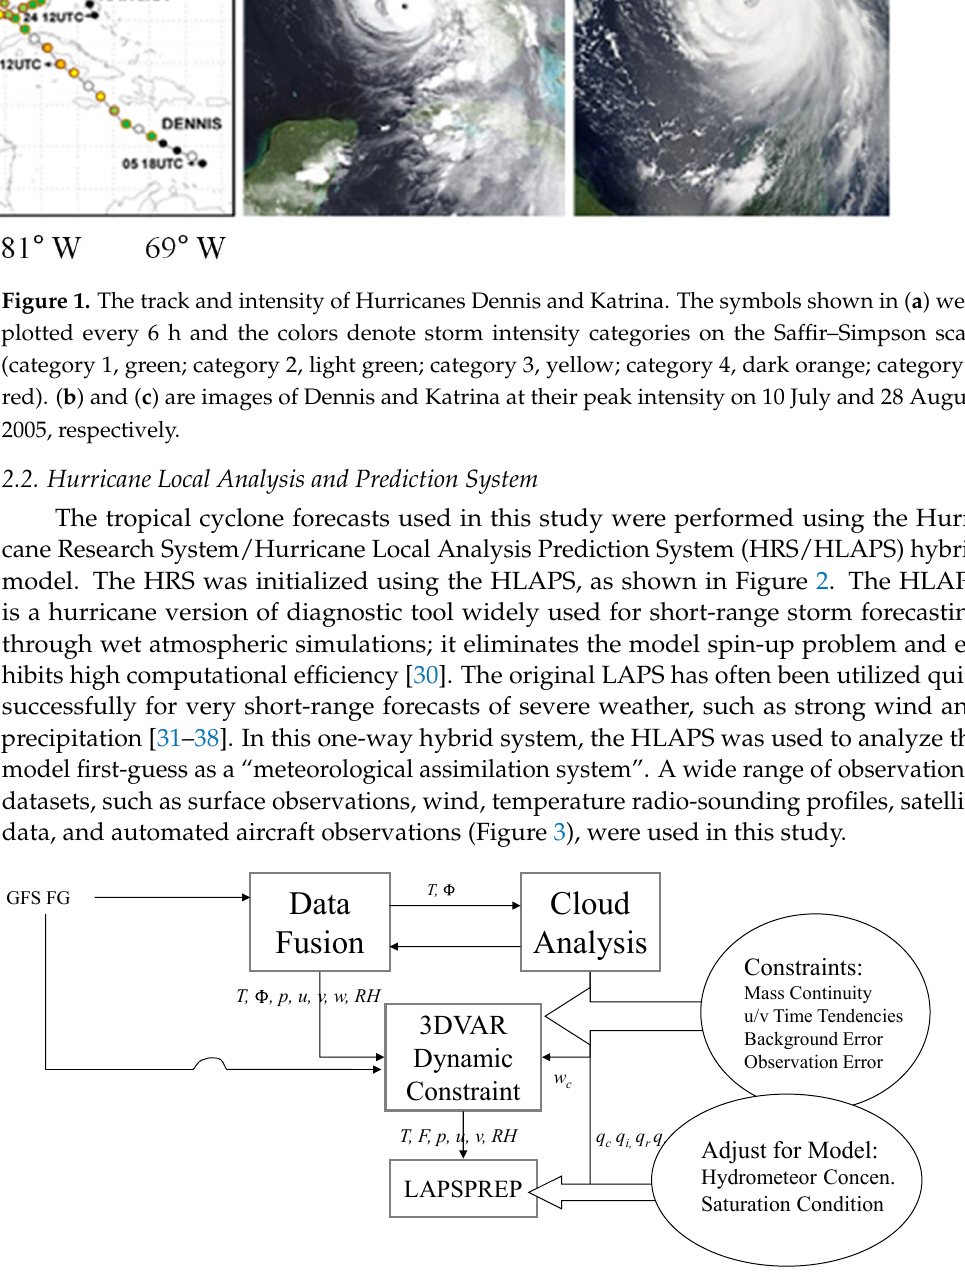
Figure 2. Schematic diagram of the Hurricane Local Analysis Prediction System (HLAPS) used in this study. T, Φ , u, v, ω , RH, qc, q, qr , and qs indicate temperature, geopotential height, wind components, relative humidity, cloud water, cloud ice, cloud rainwater, and cloud snow, respectively. Observation data obtained by NOAA aircraft were also used in this study, i.e., actual observation data from a Hurricane P3 aircraft. The type of data collected differed slightly